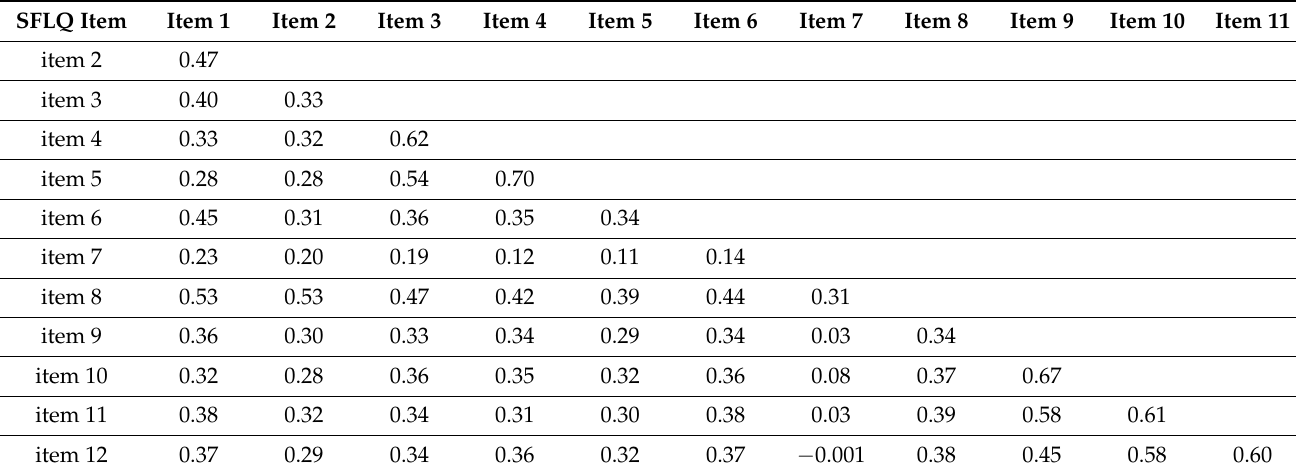
Table 2. Bivariate correlations of SFLQ